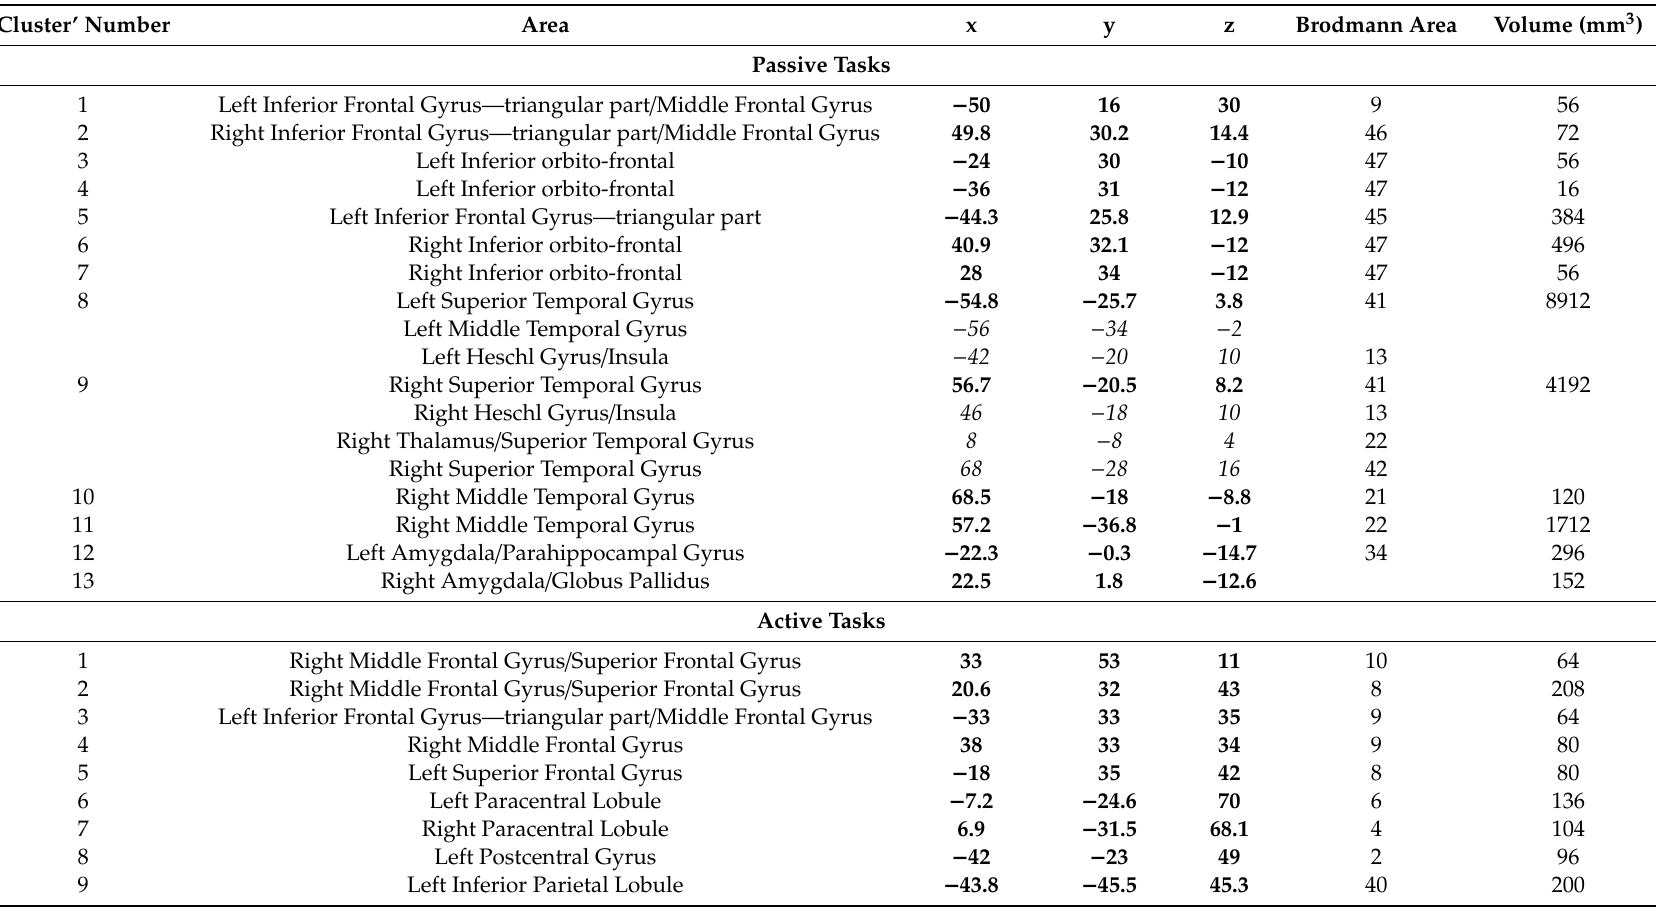
Table 4. Clusters of activation. The clusters of activation are reported for each task (both passive and active) and for each patients’ category (both unresponsive wakefulness syndrome and minimally conscious state). The brain regions are labelled according to the Automatic Anatomical Labelling (AAL [23]). Double labels are reported for those regions presenting a di ff erent anatomical location according to the mapping procedure implemented in GingerALE